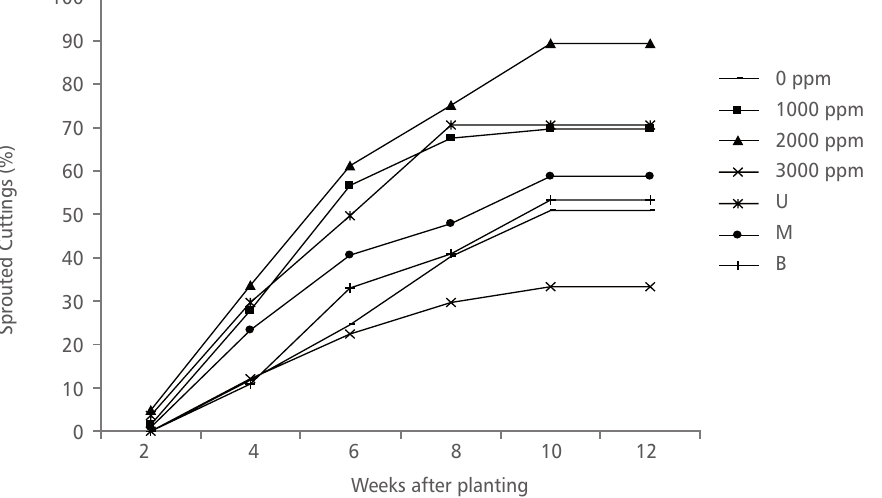
FIGURE 1. Sprouting of D. tripetala cuttings using different IBA hormone concentrations and nodal positions (U = upper node, M = middle node and B = basal node)